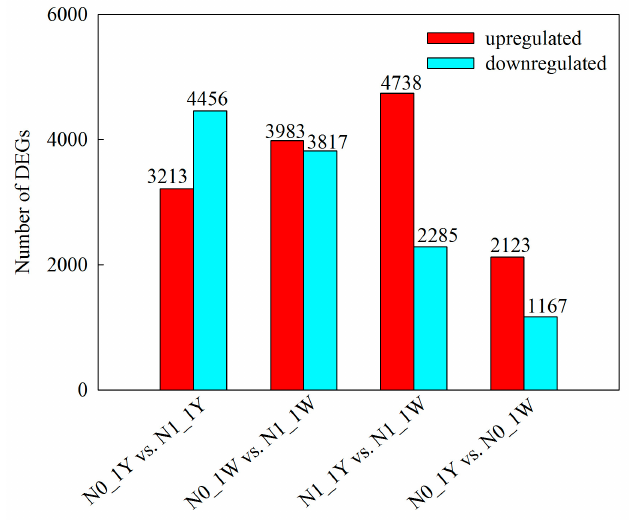
Figure 2. Number of DEGs in pairwise comparisons. The red and cyan colors of the graph represent